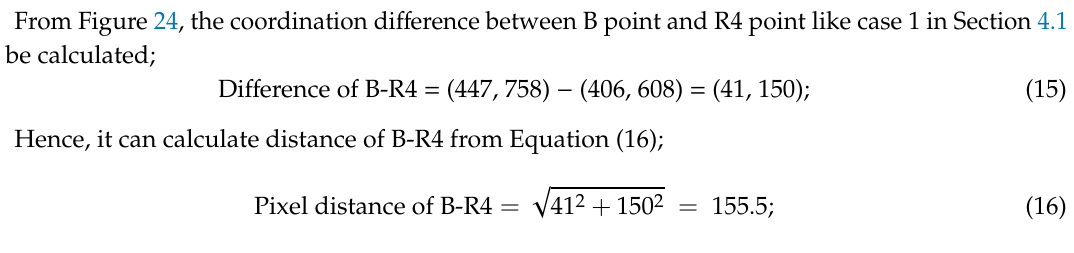
Figure 24. Coordination of B and R4.